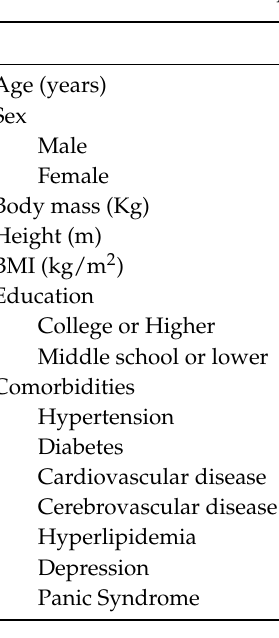
Table 1. Characteristics of the